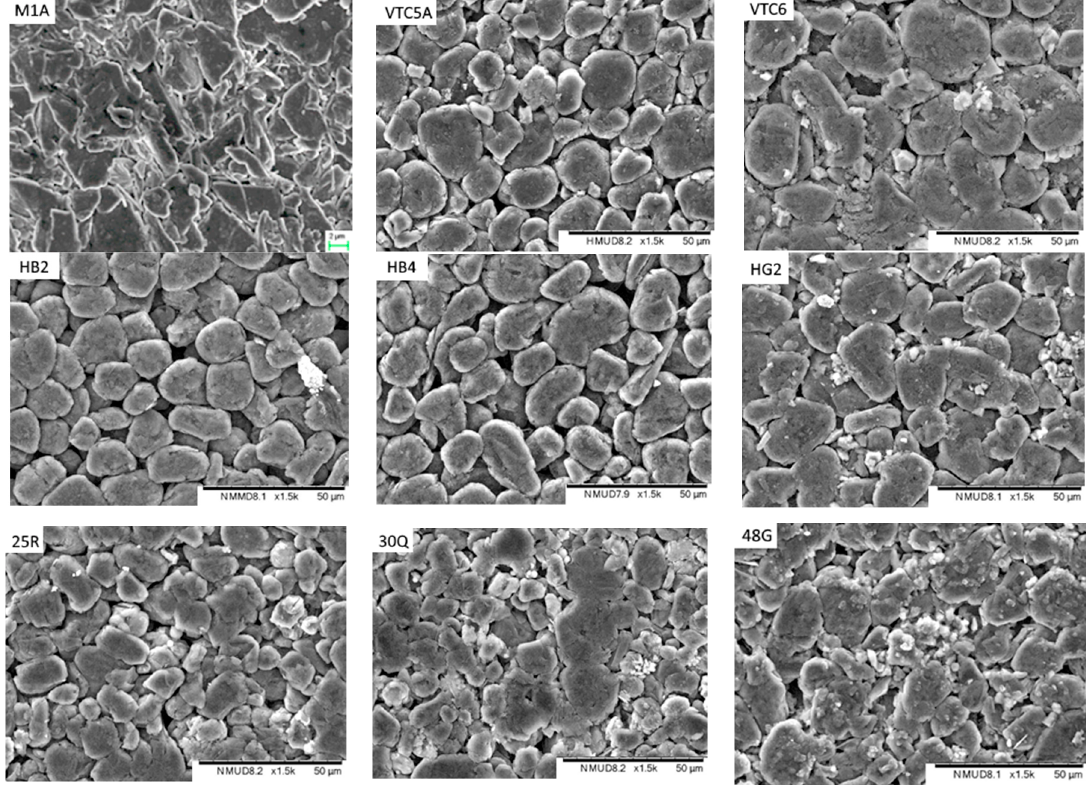
Figure 8. SEM images of anode coatings. Table 5. Active materials identified by energy dispersive x-ray spectroscopy (EDS).